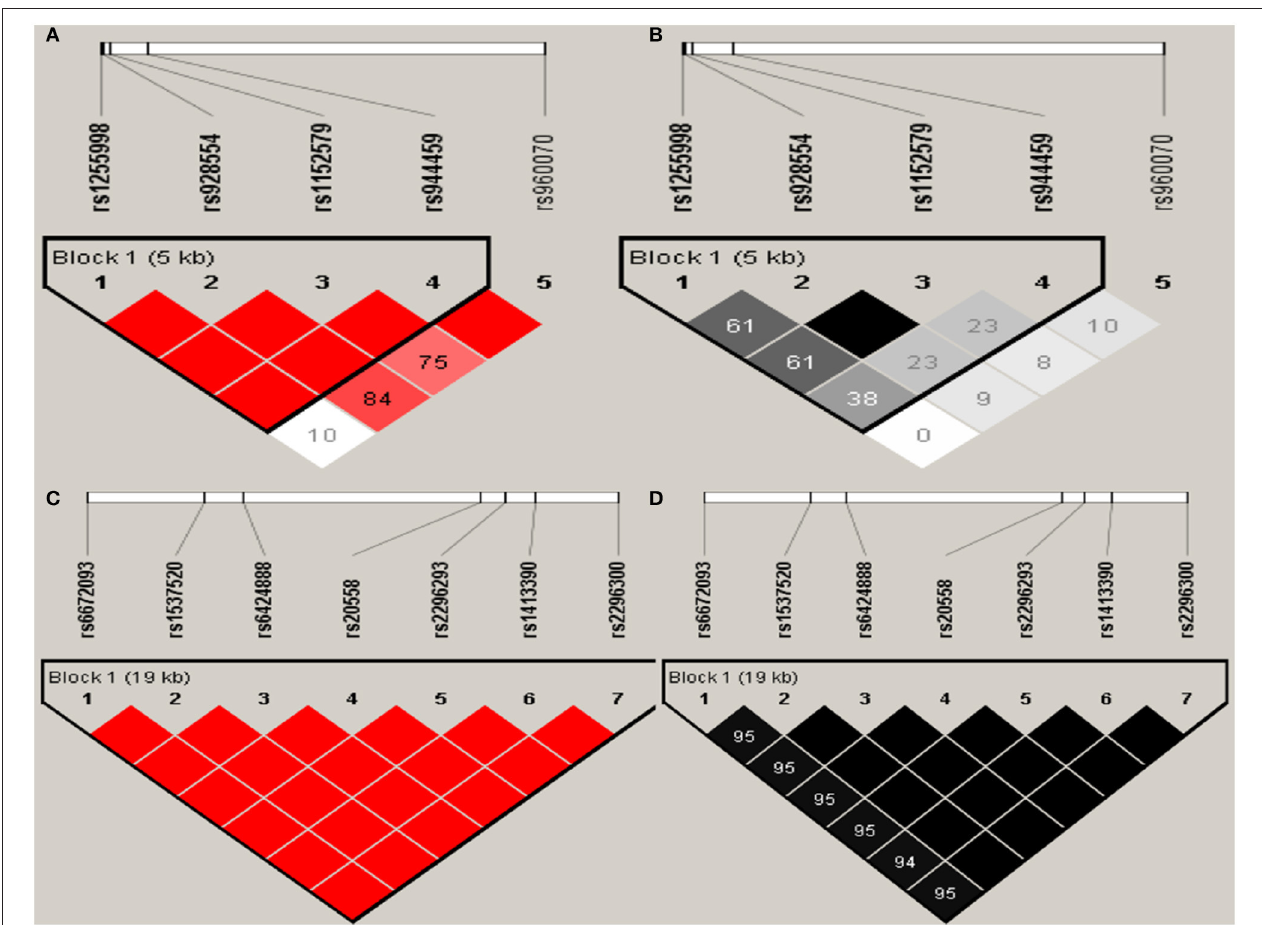
FIGURE 2 | Graphical representations of the SNP locations and LD structure of ESR2 (A,B) and LAMC1 (C,D) using tested genotyped SNPs in 331 controls.